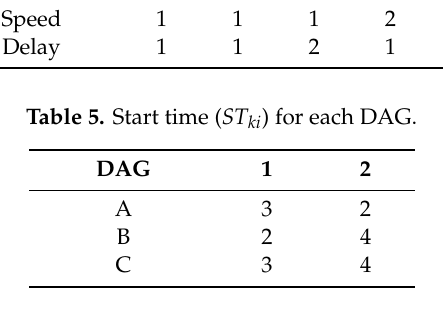
Table 6. Processing time with priority relation (PR) in DAG A.